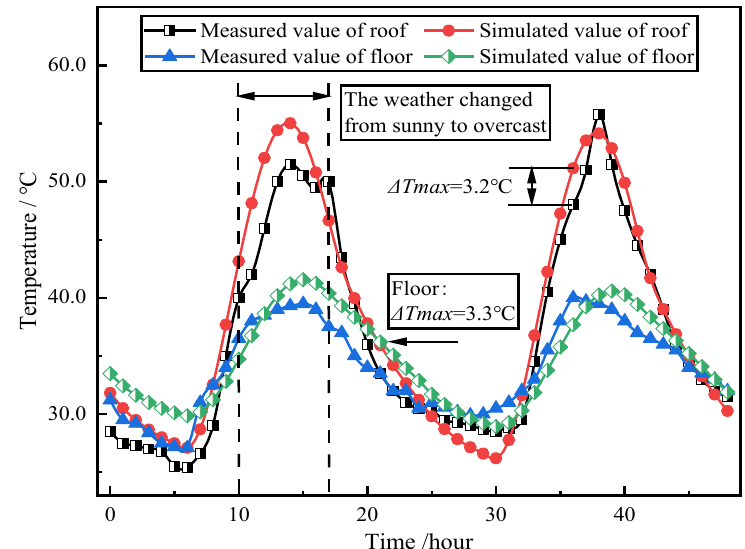
Figure 16. Temperature change curve of floor and roof.